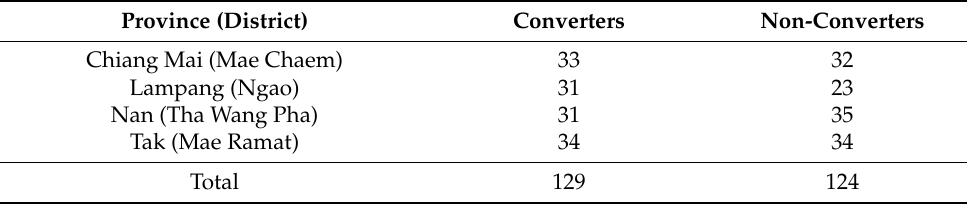
Table 3. Sample size for the household survey by province: full population